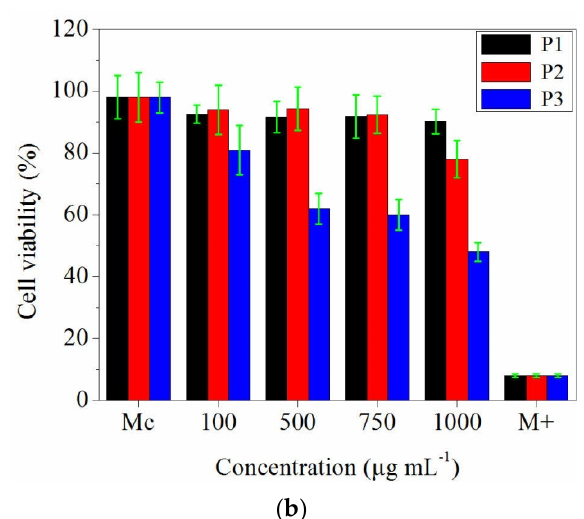
Figure 8. Cell viability of fibroblast cell line (NCTC clone L929) in the presence of prepared electrospun collagen and collagen loaded with essential oils after: ( a ) 24 h; ( b ) 48 h. P1 = collagen; P2 = collagen + thyme essential oil; P3 = collagen + oregano essential oil. Error bars represent the standard deviation. Mc = control, M+ = positive control.